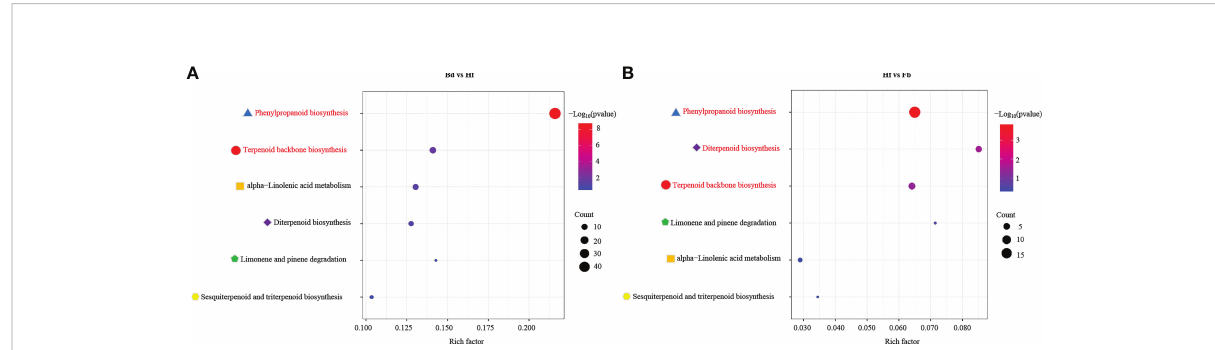
FIGURE 6 Enrichment analysis of DEGs involved in aroma-related pathway between different pairs of groups. Bd vs. Hf (A) and Hf vs. Fb (B) . Pathways with signi fi cant enrichment were highlighted by red color, and the same pathways were marked with the same color shape for comparison purposes. The rich factor was the ratio of the number of genes associated with the pathway in the DEGs to the number of genes associated with the pathway in the whole